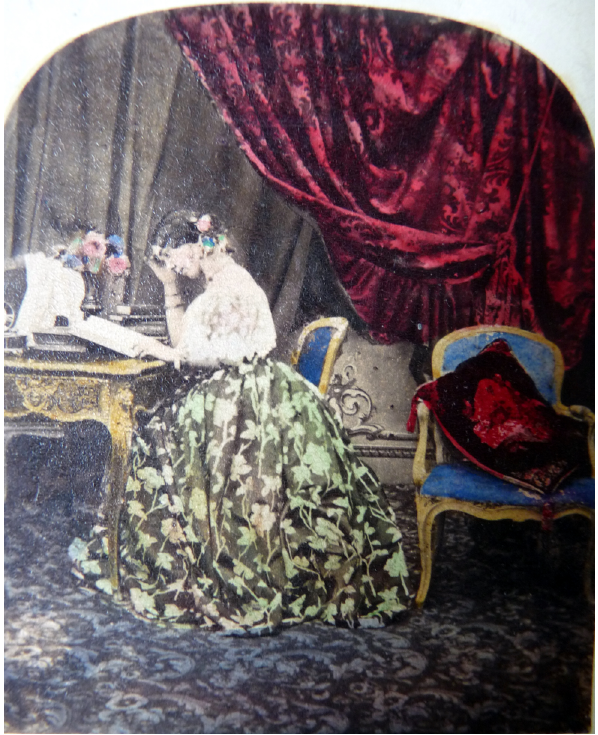
Figure 3: Image from a mid-nineteenth-century stereoview (Author’s